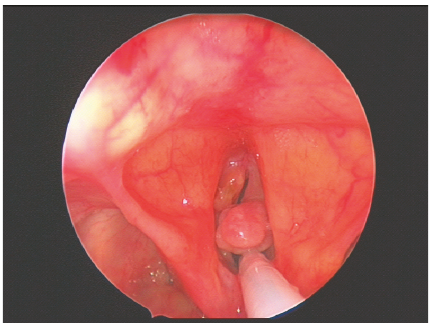
Figure 1: Direct laryngoscopy showing right vocal cord peduncu- lated lesion causing a bag-valve effect on the glottic inlet and left anterior vocal cord granulation.